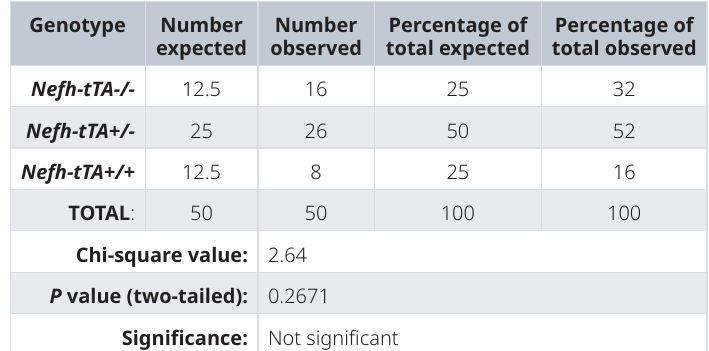
Table 5. Numbers of pups of each genotype observed using our novel PCR assay in litters from hemizygous intercrosses compared